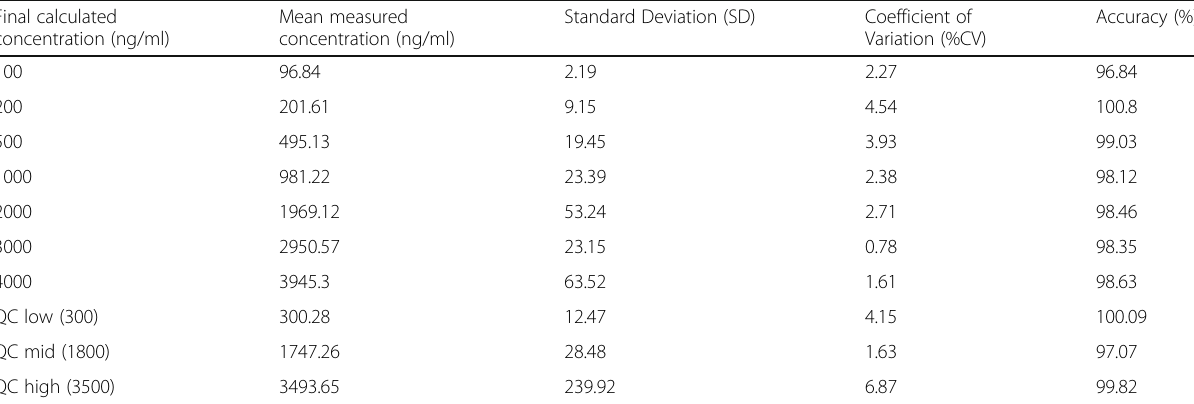
Table 1 Accuracy percentage based on the measured warfarin concentrations of standard points and QC samples. The mean measurements are for day 1, day 2 and day